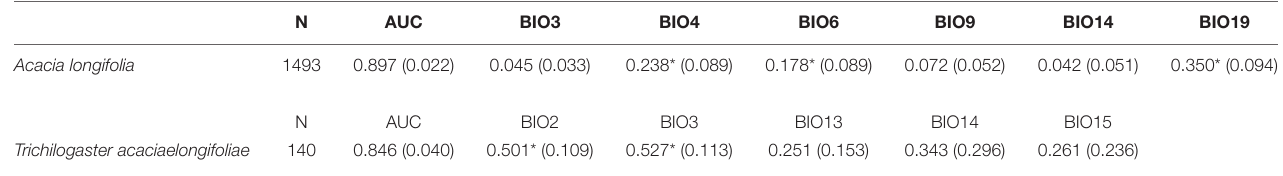
TABLE 3 | Number of occurrence records (N), average (and SD) Area Under the Curve (AUC) and average (and SD) permutation importance of each ecogeographical variable across all 280 species distribution model replicates for Acacia longifolia and Trichilogaster acaciaelongifoliae. ∗ Indicate highest contributing variables. N